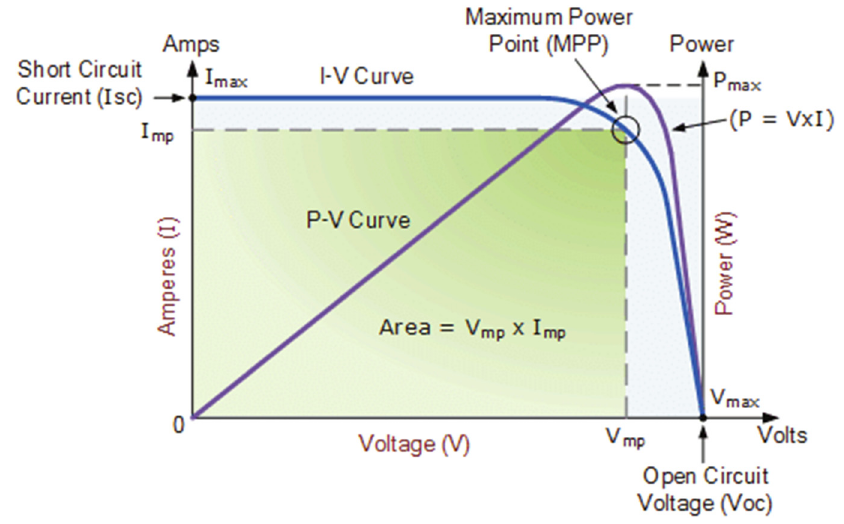
Figure 3. The I ‐ V and P ‐ V curves. Figure 3. The I-V and P-V